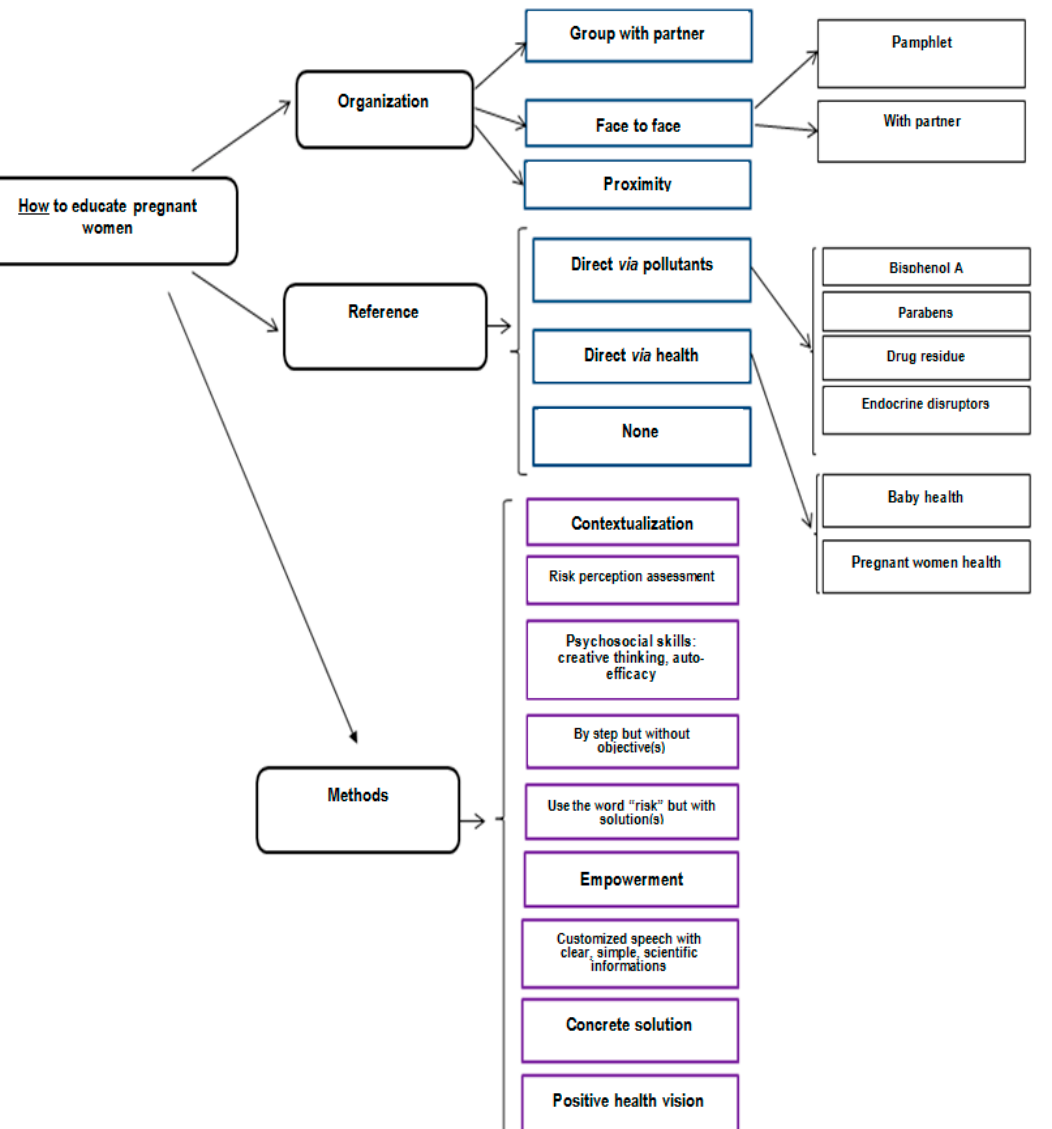
Figure 3. Perception of professionals on “how to educate pregnant women”.